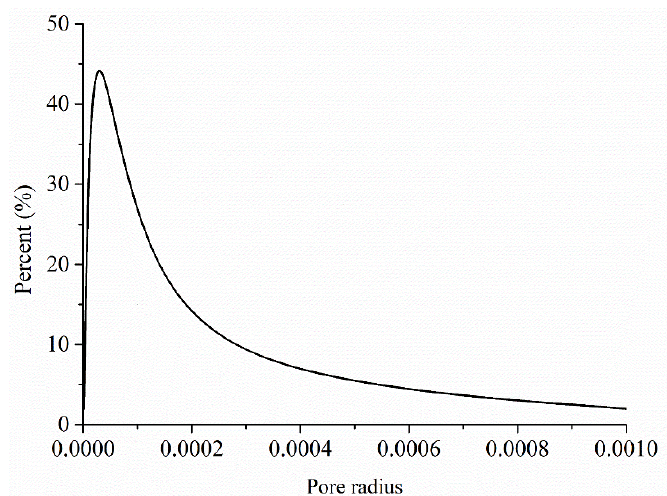
Figure 6. Pore size distribution. Table 1. Numerical boundary